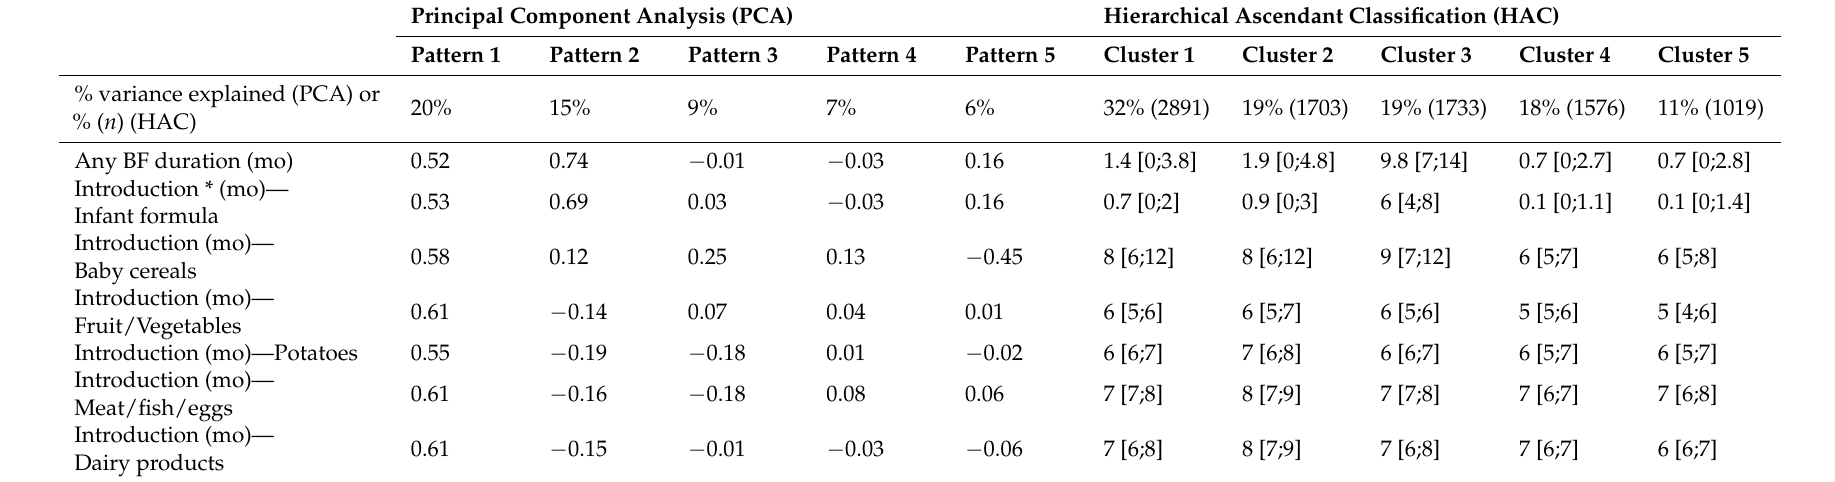
Table 2. Analysis of core variables (BF and main food groups) and food pieces, Set B of variables ( n =